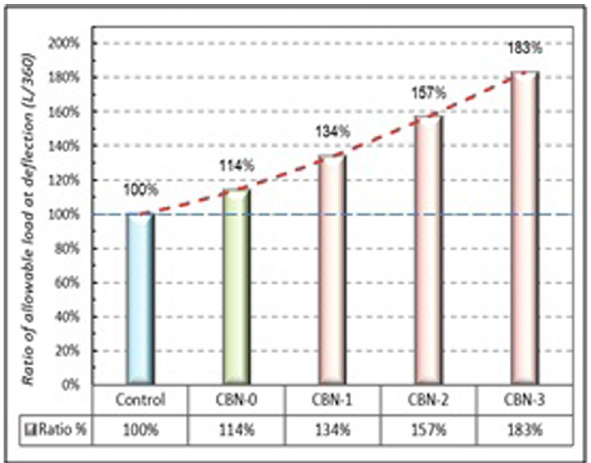
Figure 18: Ratio of allowable load of specimens to control at de fl ection ( L/360 )